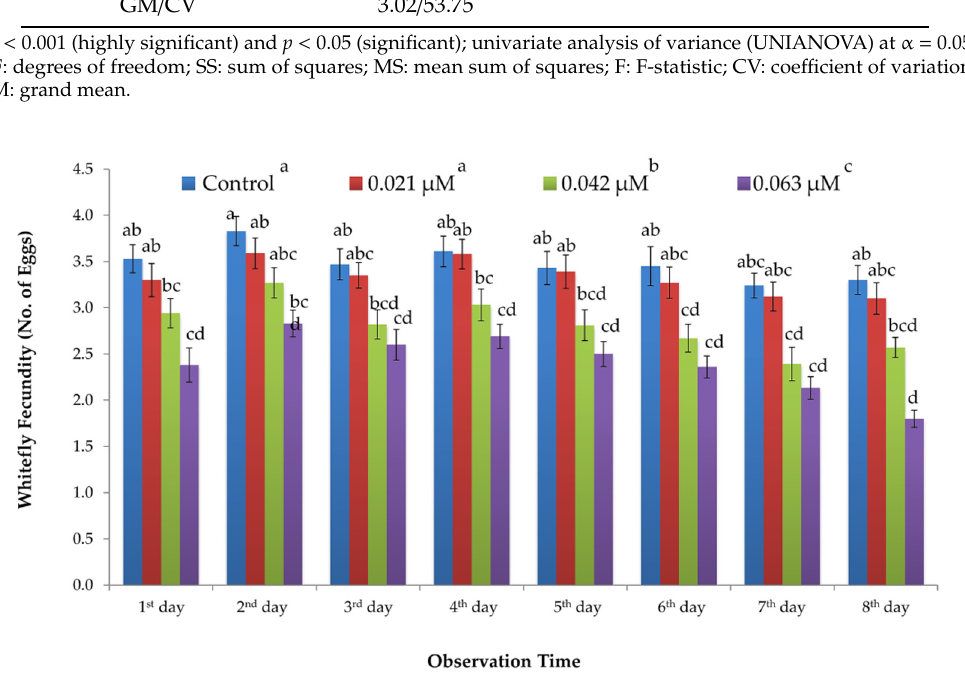
3.02/53.75 * p < 0.001 (highly significant) and p < 0.05 (significant); univariate analysis of variance (UNIANOVA)